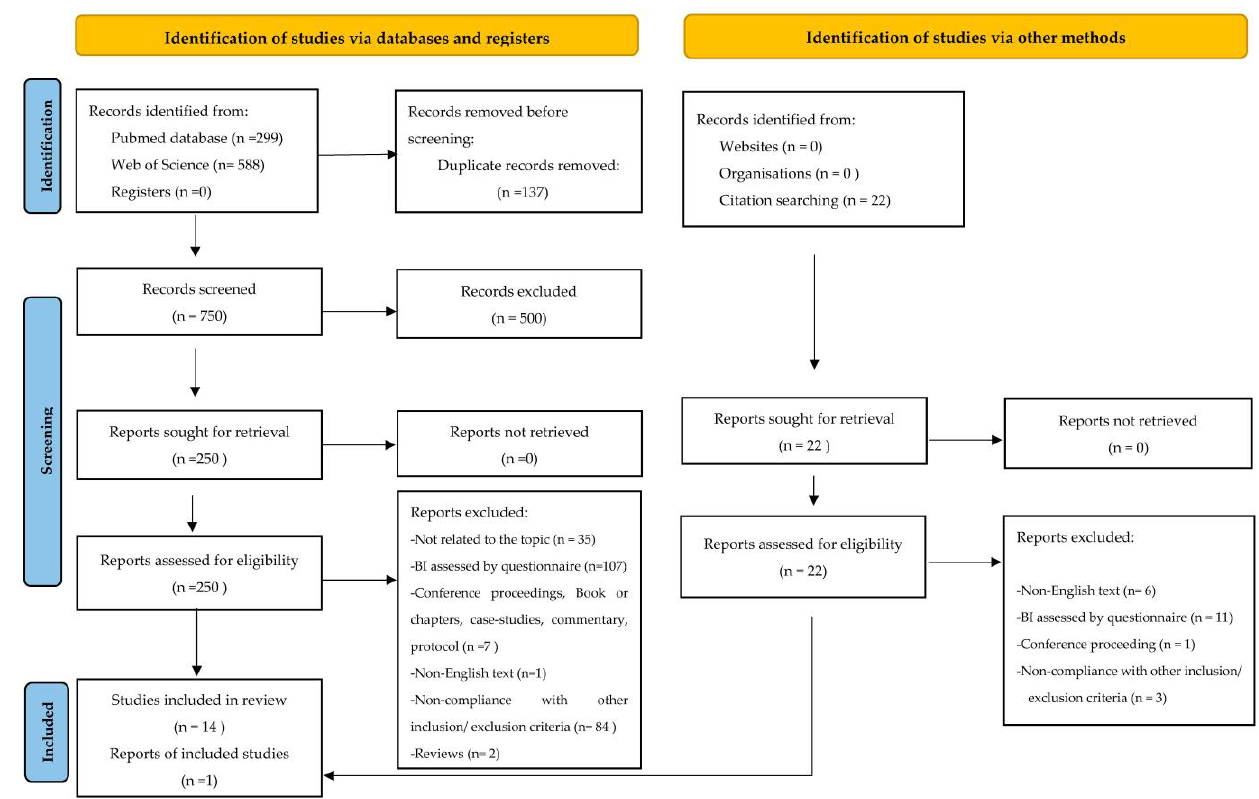
Figure 1. Flow chart of the study selection process (PRISMA 2020 flow diagram) [22].